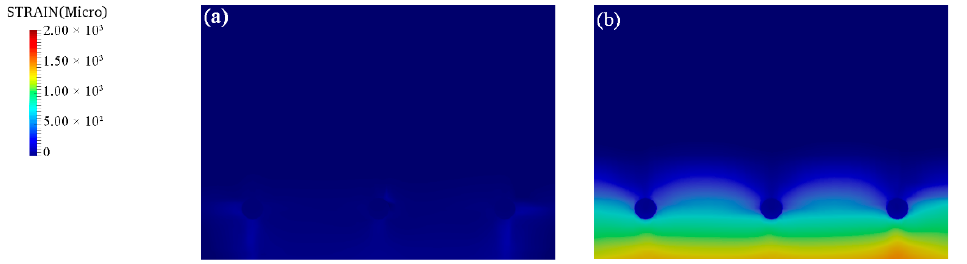
Figure 10. The load-induced strain of the beam section under different loading conditions (surface cracking moment): ( a ) S-L00 and ( b )